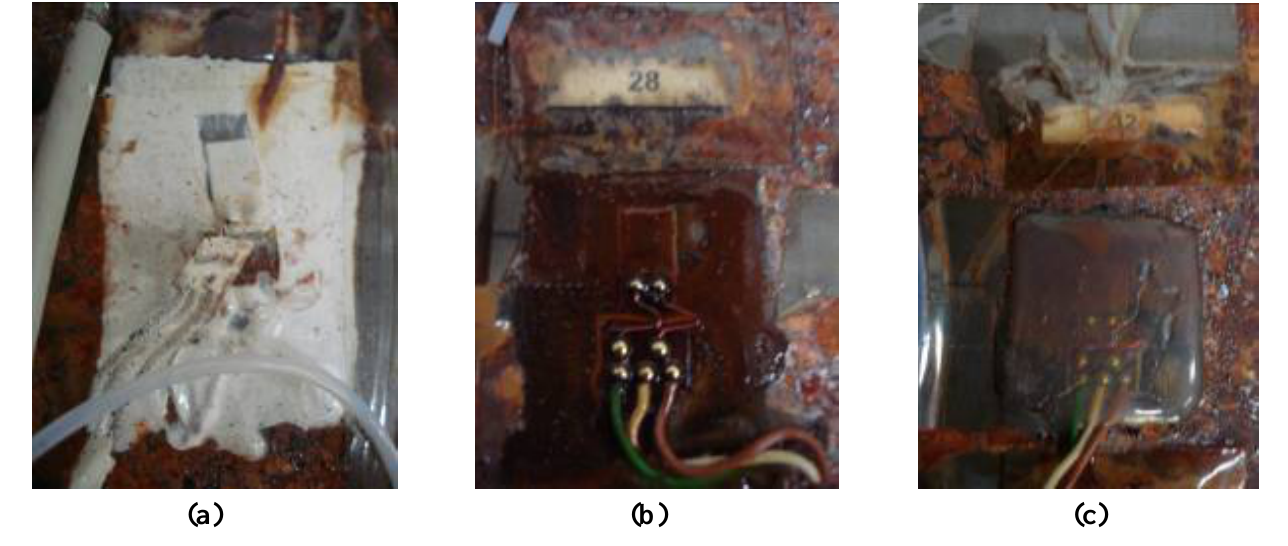
Figure 14. State of gauges after aging. The strain gauge 31 can be seen almost